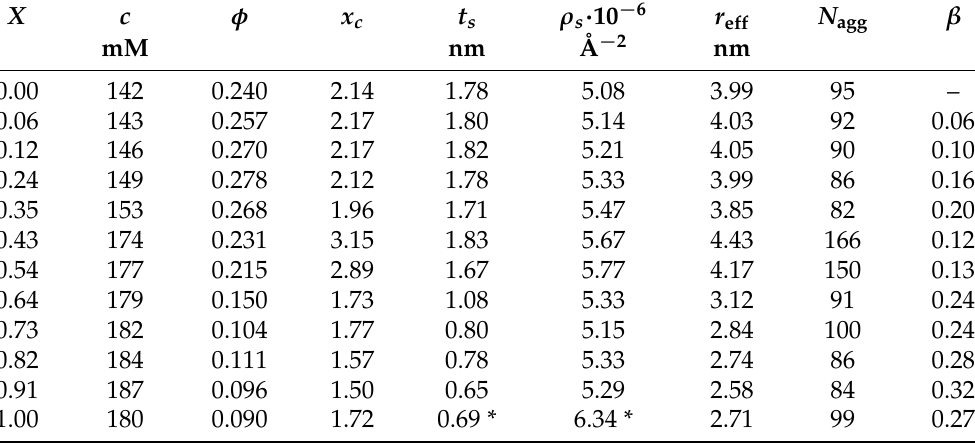
Table 6. Parameters extracted from SANS model fits (core-shell ellipsoid form factor + RMSA structure factor; pure Tween20: HS-PY structure factor) of mixed SDS/Tween20 surfactants in D 2 O at 20.0°C (* fixed